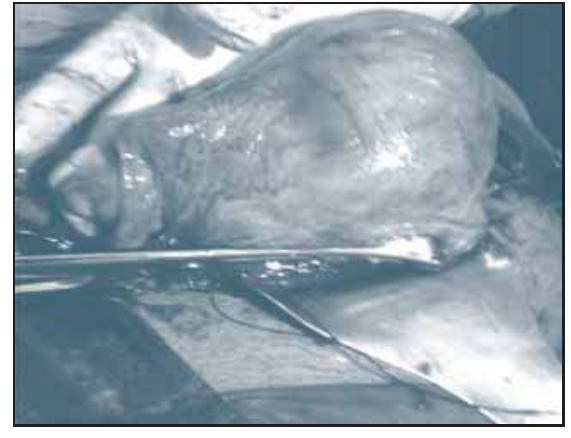
Figure 2. Case 3.Excised rudimentary horn, tube and